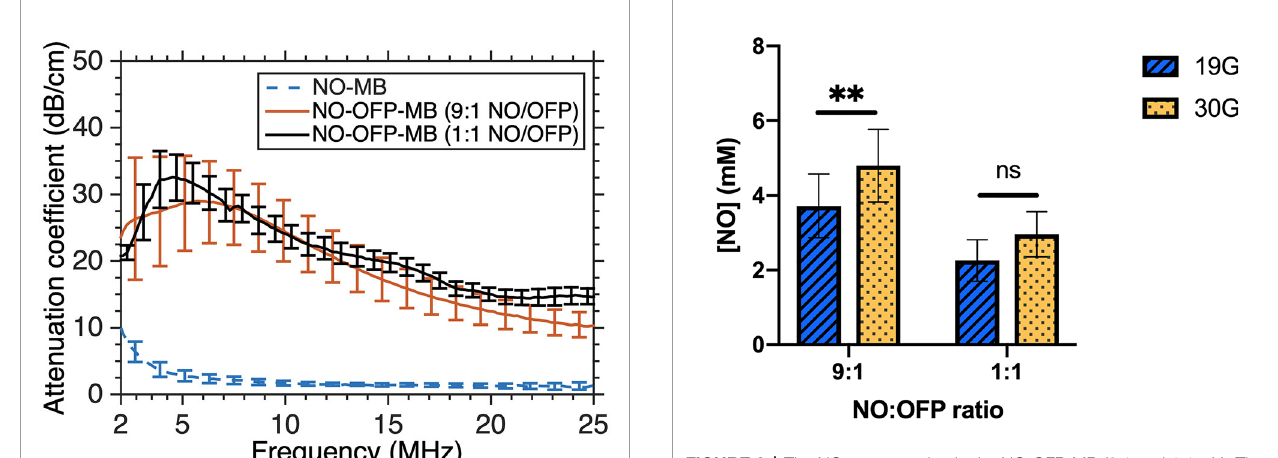
FIGURE 9 | The NO concentration in the NO-OFP-MB (9:1 and 1:1 v/v). The mean ± 1 standard deviation is depicted. n = 9 per group except for 9:1 30- G (n = 10). The symbols ‘ ns', and ‘ **' represent p -values > 0.05, and < 0.01, respectively. NO-OFP-MB, Nitric oxide and octa fl uoropropane microbubbles. The difference between panel A and B is that A is 9:1 v/v and B is 1:1 v/v. Please change caption to read, "(Panel A: 9:1 v/v, Panel B: 1:1